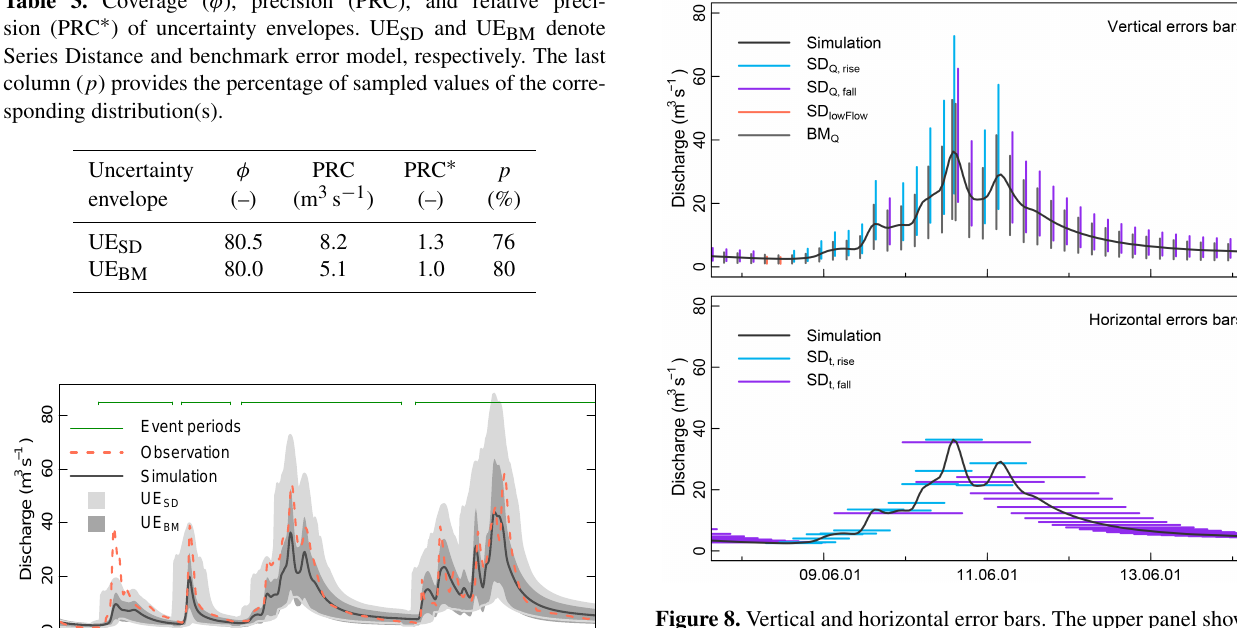
Figure 8. Vertical and horizontal error bars. The upper panel shows magnitude error bars ( Q ) for the Series Distance (SD) method and the benchmark (BM) approach. For SD different error bars are drawn for low-flow conditions and rising (rise) and falling (fall) limbs. In the BM case the same error bars are applied in all cases. The lower panel shows the corresponding timing error bars ( t ) of SD (not available for BM), again separately for the rising and falling limbs. To improve readability we plotted error bars only every third hour and introduced a slight time offset between SD and BM (upper panel only). Both panels show a subset of the hydrograph section depicted in Fig. 7 and are based on the same